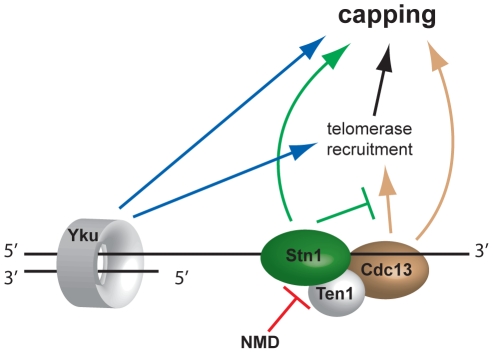
Model of telomere capping activities influenced by NMD.Disruption of NMD activity results in higher Stn1 transcript and protein levels (Figure 5). Stn1 promotes capping directly and is thought to oppose telomerase recruitment through interaction with Cdc13. Since telomerase has telomere capping function, Stn1 therefore both promotes and inhibits telomere capping.